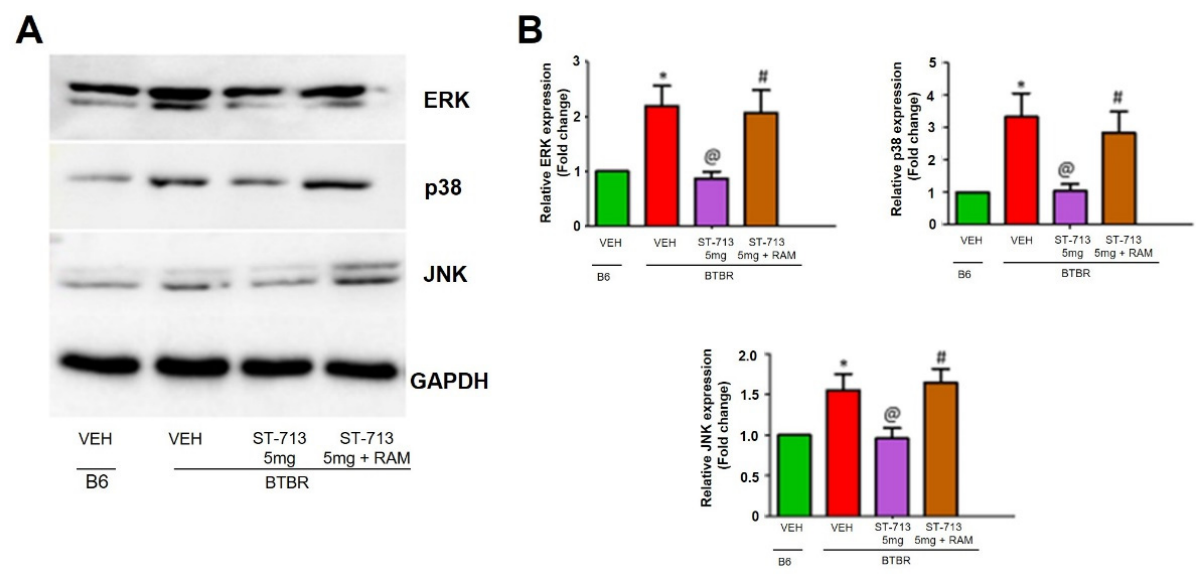
Figure 3. ST-713 modulated MAPK pathway proteins in B6 and BTBR mice. ( A ) Western blot patterns of anti-ERK, anti-p38, and anti-JNK levels in the brain tissues of all tested mice. The protein expression levels and corresponding results are depicted as fold change to the controls. The BTBR mice showed significantly elevated levels of ERK, p38, and JNK when compared to the VEH-treated B6 group. BTBR mice pretreated with ST-713 (5 mg/kg, chronic administration) significantly decreased the expression levels of ERK, p38, and JNK. ( B ) Bar graph represents the relative intensities of ERK, p38, and JNK levels. The multiple-active test compound at a dose of 5 mg/kg provided beneficial effects which were abrogated by ( R )- α -methylhistamine (RAM, 10 mg/kg). The column heights represent the mean ± SEM (n = 3). @ p < 0.05 vs VEH-treated BTBR group: * p < 0.05 vs. VEH-treated B6group; # p < 0.05 vs. ST-713 (5 mg/kg).